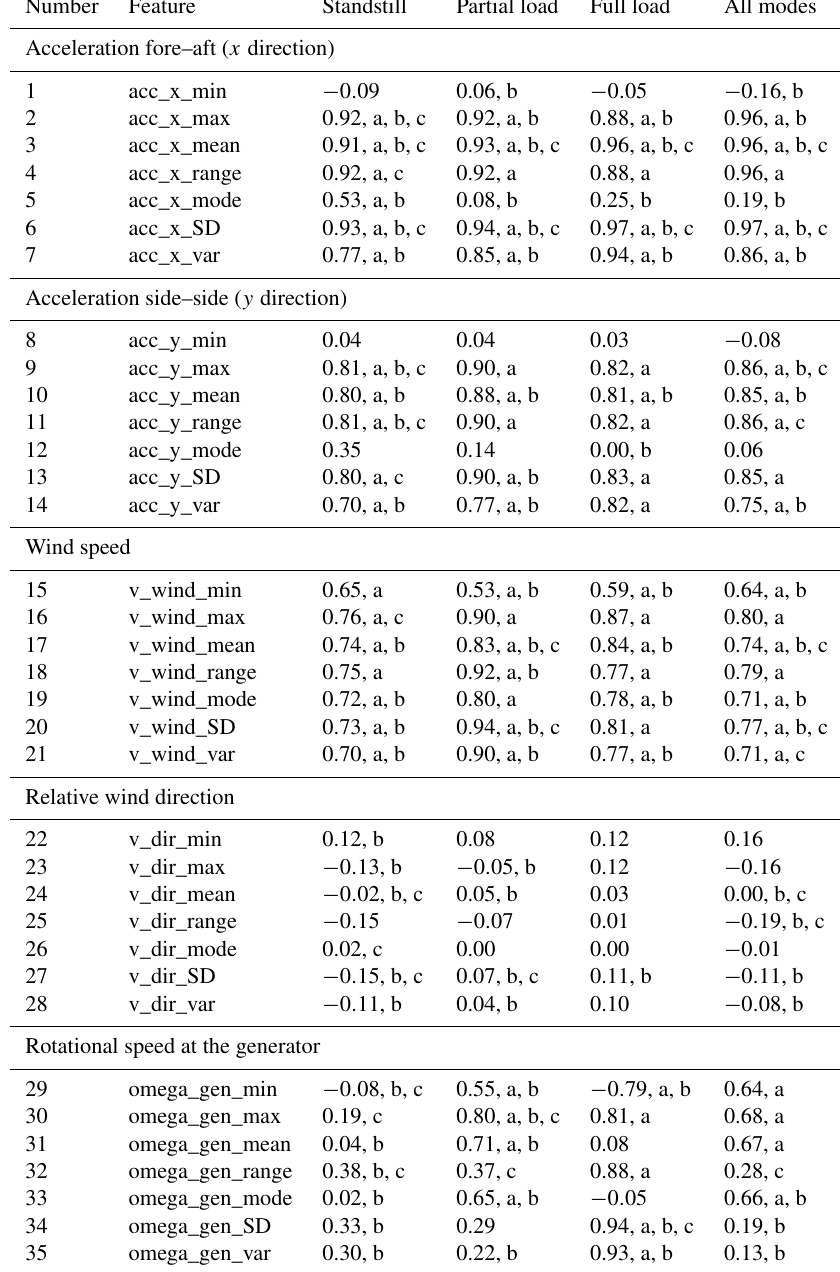
Table A1. Feature selected by the different methods and for the different operational modes. Note that the numbers correspond to the Pearson correlation coefficient. The letters next to the coefficients indicate that the feature has been selected by the method: “a” corresponds to correlation analysis, “b” to stepwise regression, and “c” to